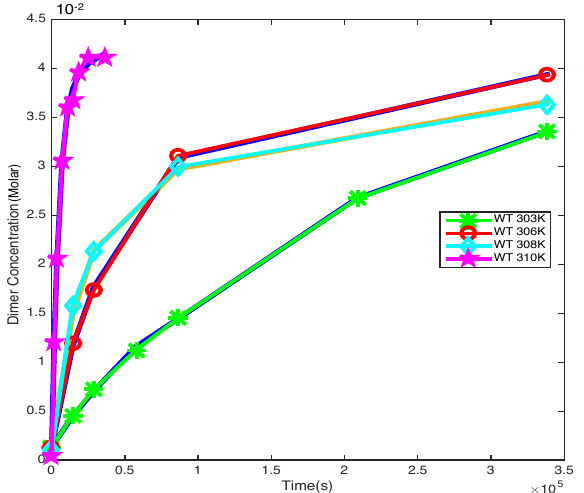
Figure 5. AKPE fitting of experimental data at various temperatures. The experimental curves are drawn as blue lines while neural network curve are represented as colored lines interspersed with markers: 303 K (30 ◦ C) as green lines with flower markers, 306 K (33 ◦ C) with red lines and circular marker, 308 K (35 ◦ C) with cyan lines with diamond markers and purple lines represents 310 K (37 ◦ C) with star markers, reaction speed at 310 K is faster, which account for the shorter